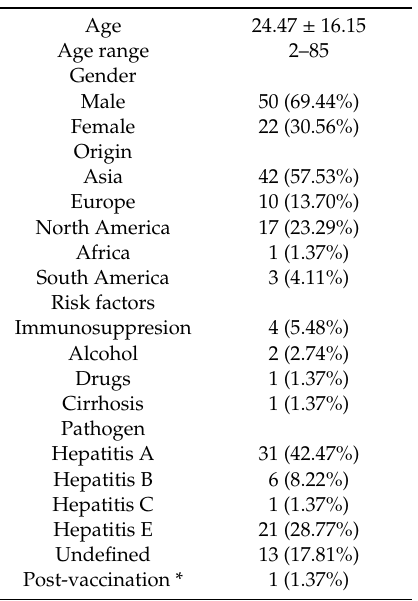
Figure 1. The search strategy and flow diagram for databases search. Table 1. Demographics and risk factors in 73 patients with viral hepatitis diagnosed with